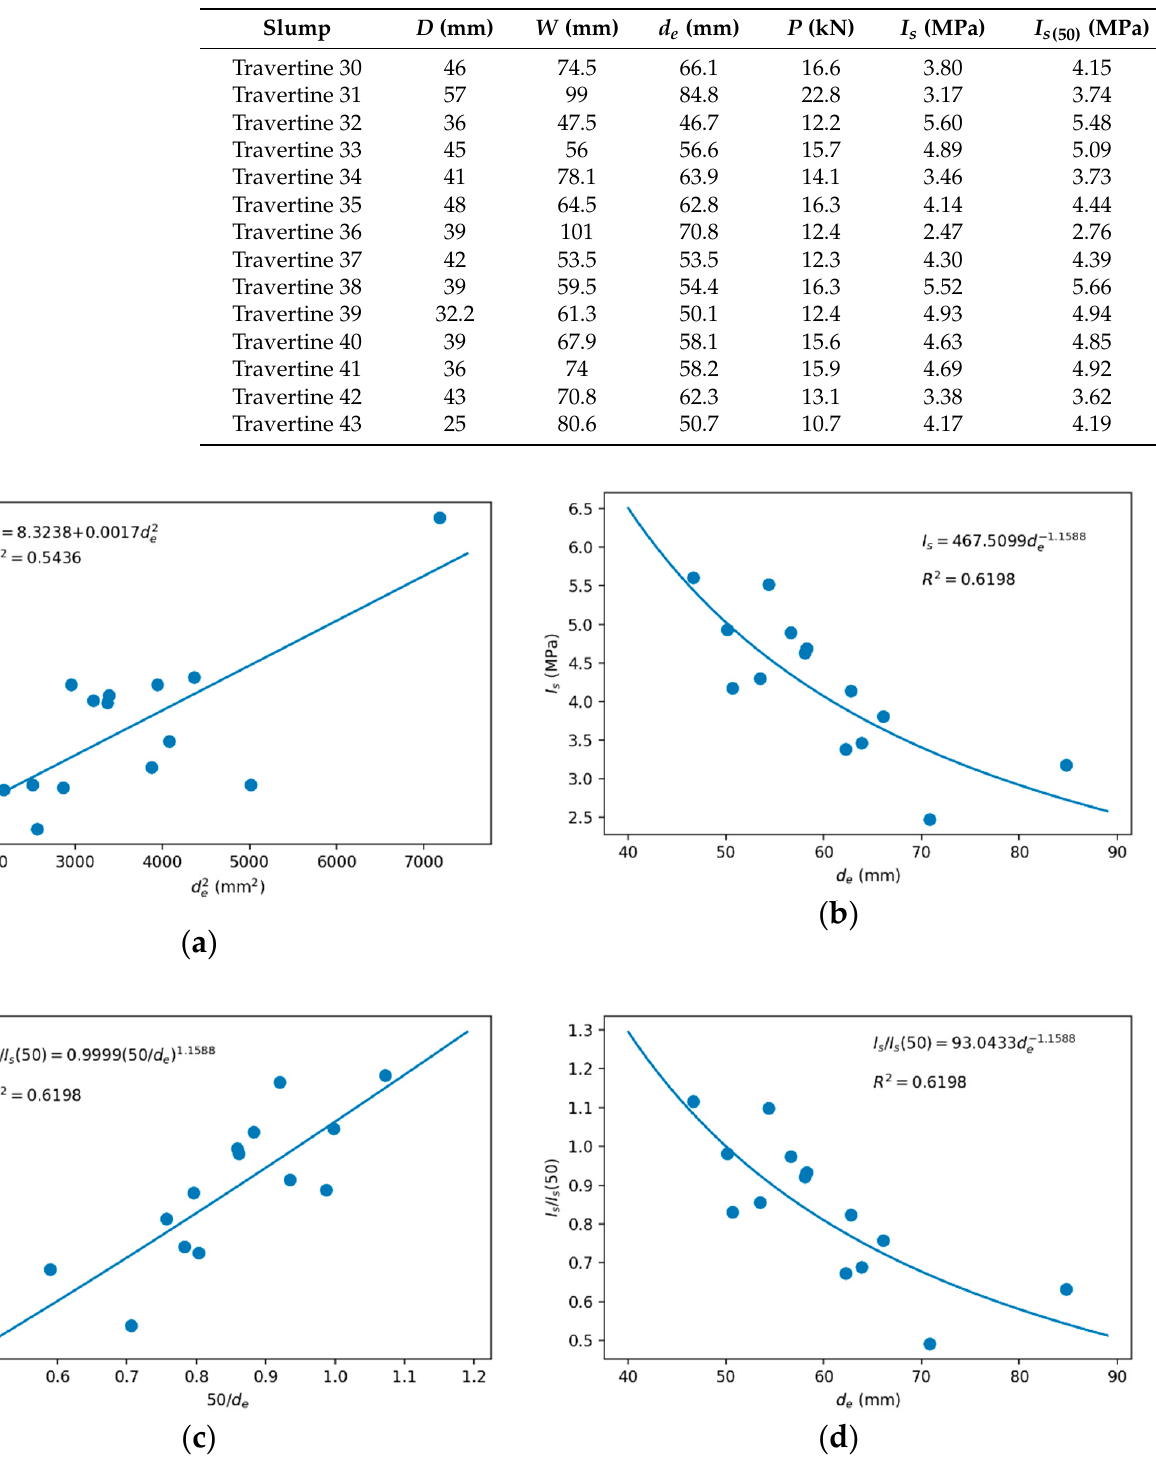
Figure 3. Scale effect for the point load index of the travertine: ( a ) quadratic fit of P–d e and ( b ) potential fit of I s –d e , to determine the referential value of I s (50) ; ( c ) potential fit of I s / I s (50) –50/ d e and ( d ) I s / I s (50) – d e to determine k 2